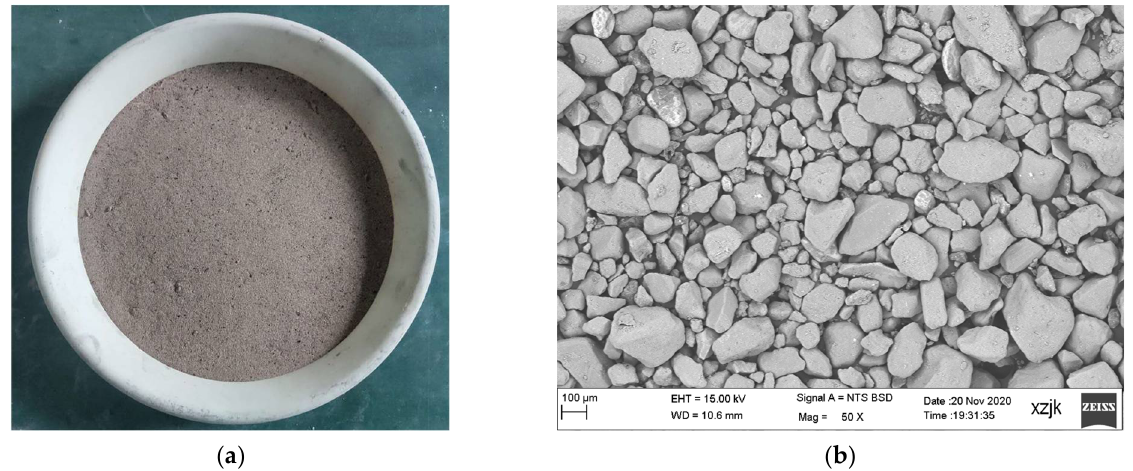
Figure 2. A photo of the aeolian sand ( a ) and microscopic structure of aeolian sand 50× ( b ).